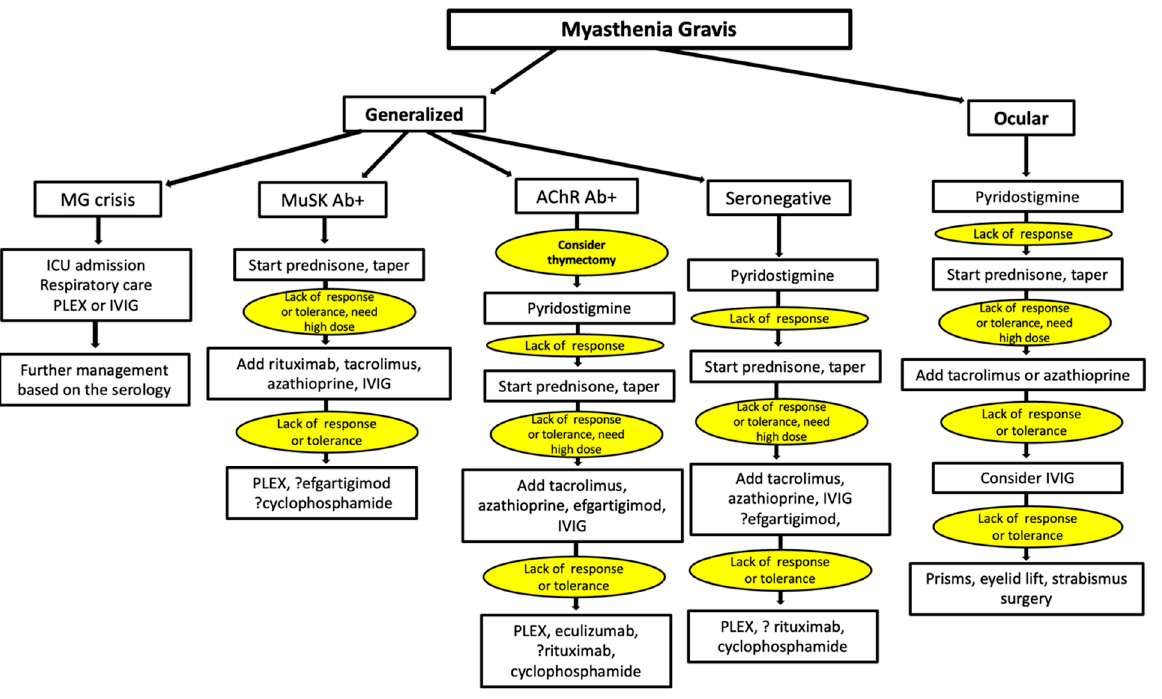
Figure 2. Overall treatment strategy of myasthenia gravis. MuSK: muscle specific tyrosine kinase; Ab: antibody; AChR: acetylcholine receptor; IVIG: intravenous immunoglobulin; PLEX: Plasma ex- change.